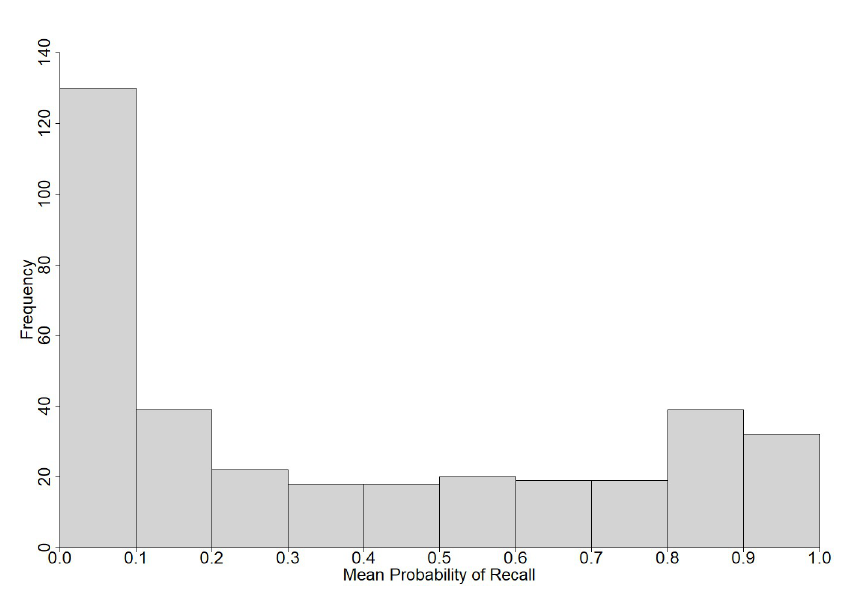
Fig 1. Histogram of the mean probability of recall for all questions.